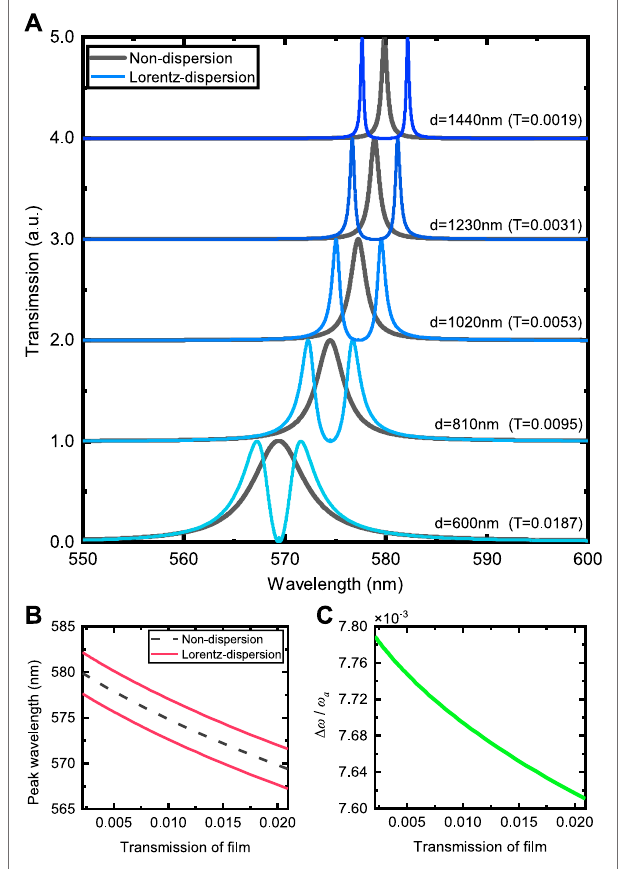
FIGURE 5 | The change of transmission peaks along with the transmission of the cavity mirror fi lm by changing the thickness of the mirror wall. (A) Transmission spectrum in the non-dispersion situation. The peak red shifts and narrows as the thickness of the wall increases (the transmissionofmirrorwalldecreases).Thenotesonthecurveindicatethewall thickness in unit of nm, together with the wall transmittance in the basket. (B) The transmission peaks position. Two peaks in Lorentz-dispersion (red solid line) surround the single peak in non-dispersion (gray dotted line). (C) The relative splitting degree Δω / ω a decreased as transmittance of fi lm